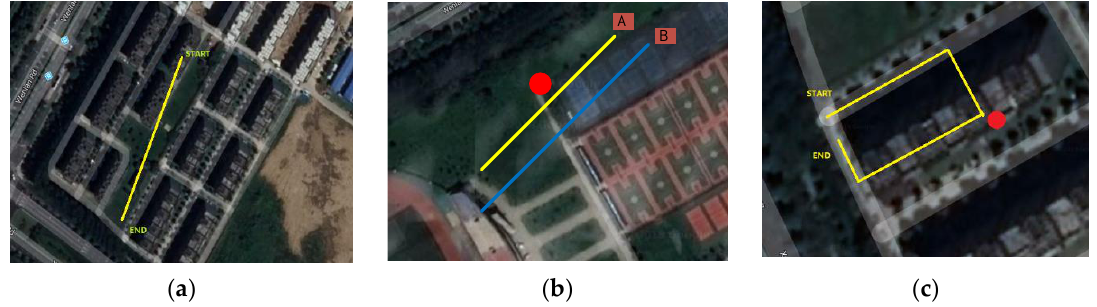
Figure 9. Testing scenarios for the proposed integrated positioning system: ( a ) testing the positioning effect of GNSS/INS; ( b ) testing the correction effect under the interference of different magnetic field strength; and ( c ) testing platform seamless positioning performance.